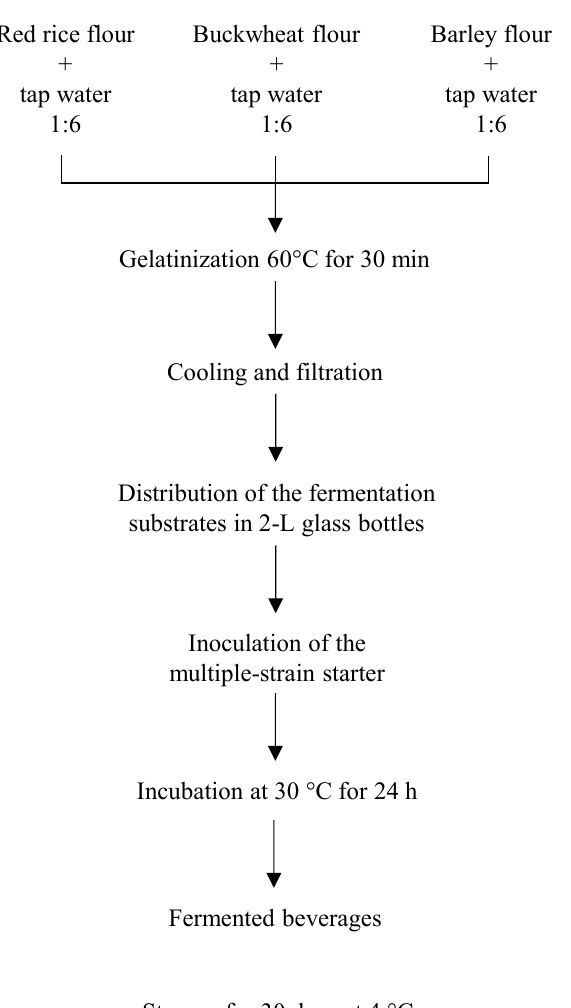
Figure 2. Production of laboratory scale prototypes of fermented beverages. Aliquots (1000 mL) of the three substrates were separately distributed into 2 L sterile glass jars, inoculated (in duplicate) with the specifically formulated multiple strain starter culture under sterile conditions, closed with non-hermetic lids, and incubated at 30 °C for 24 h. For each fermentation substrate, a uninoculated control was also incubated (in duplicate) under the same conditions.